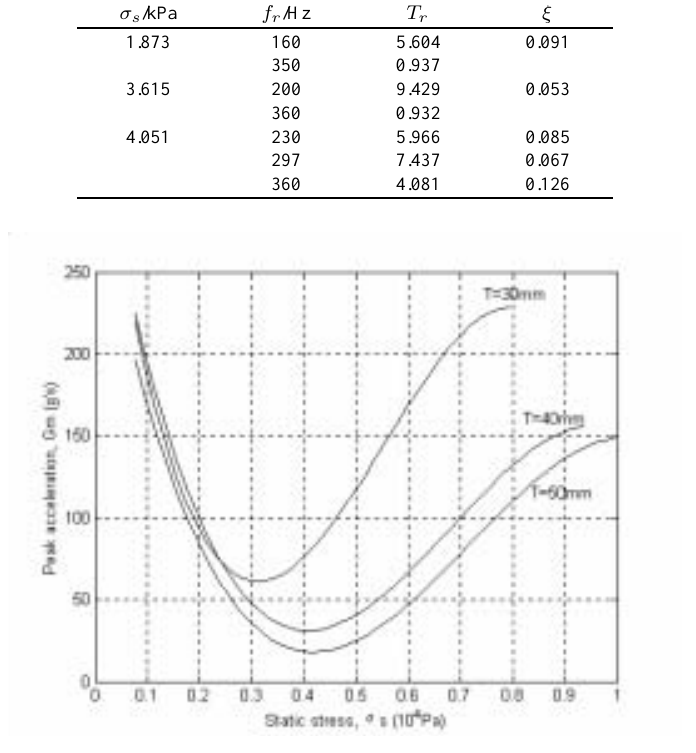
Fig. 11. Dynamic cushion curves of the honeycomb paperboards ( DH = 90